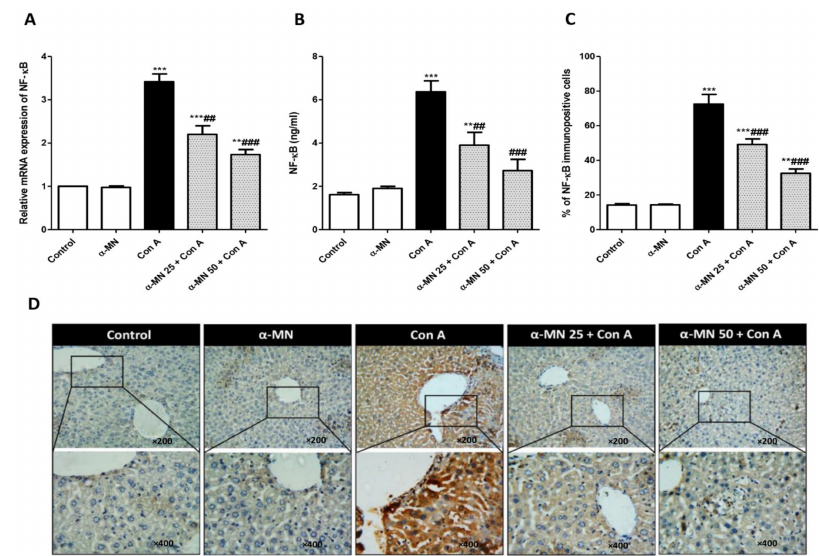
Figure 7. Alpha-mangostin ( α -MN) inhibited concanavalin-A (Con A)-induced activation of the NF-kB signaling in the hepatic tissue. ( A ) mRNA expression NF-kB p65; ( B ) Level of NF-kB; ( C ) % of the NF-kB immuno-positive cells; ( D ) Immuno-expression of NF-kB where control and α -MN groups exhibited minimal NF-kB immuno-staining, Con A group showed intense NF-kB immuno-staining; Both groups of α -MN + Con A exhibited low immuno-staining for NF-kB. Data are the mean ± SE. ( n = 8). ** p < 0.01, *** p < 0.001 vs. control group; ## p < 0.01, ### p < 0.001 vs. Con A group (one-way ANOVA).